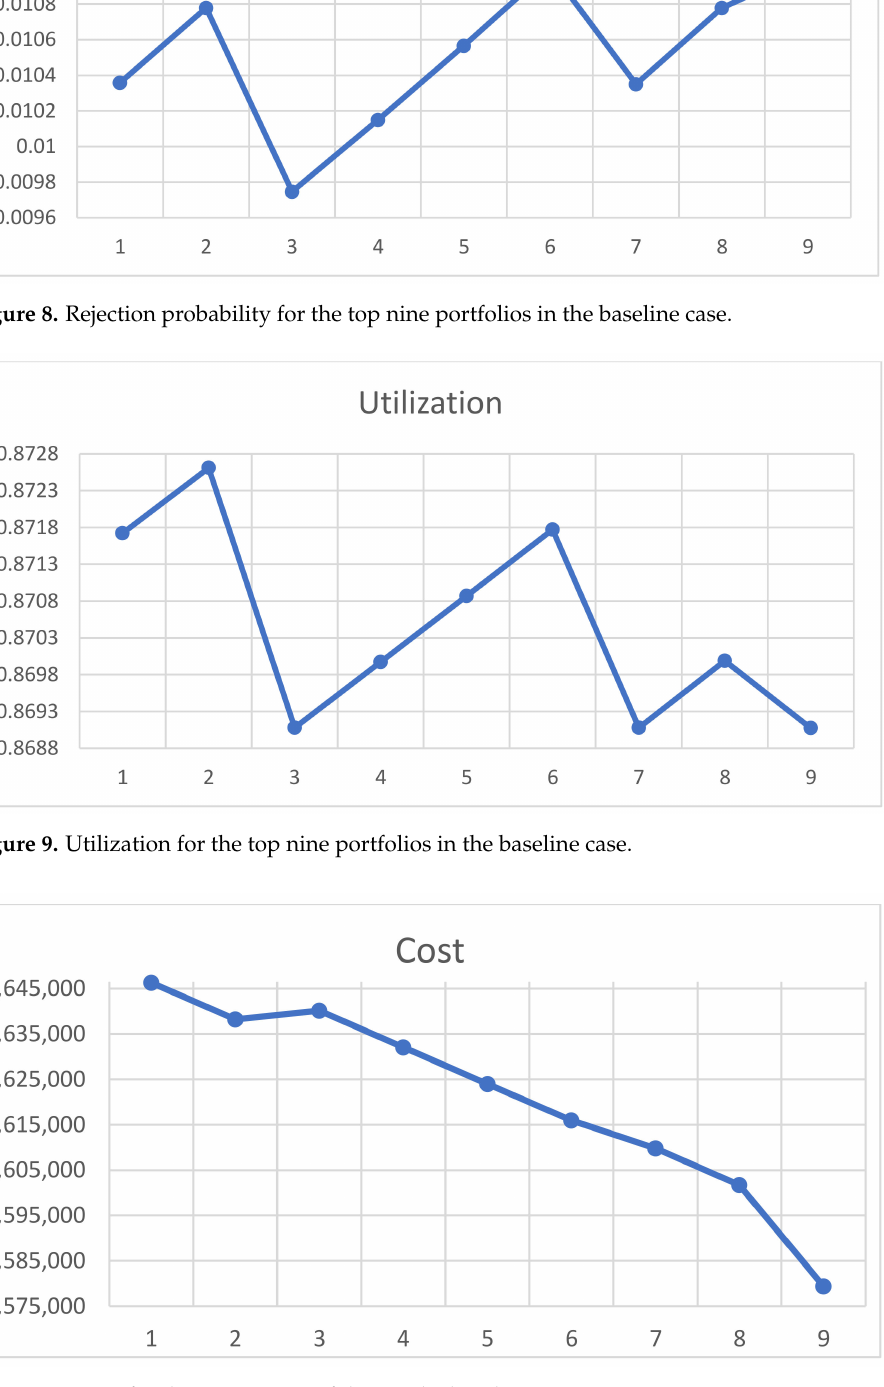
Figure 10. Cost for the top nine portfolios in the baseline